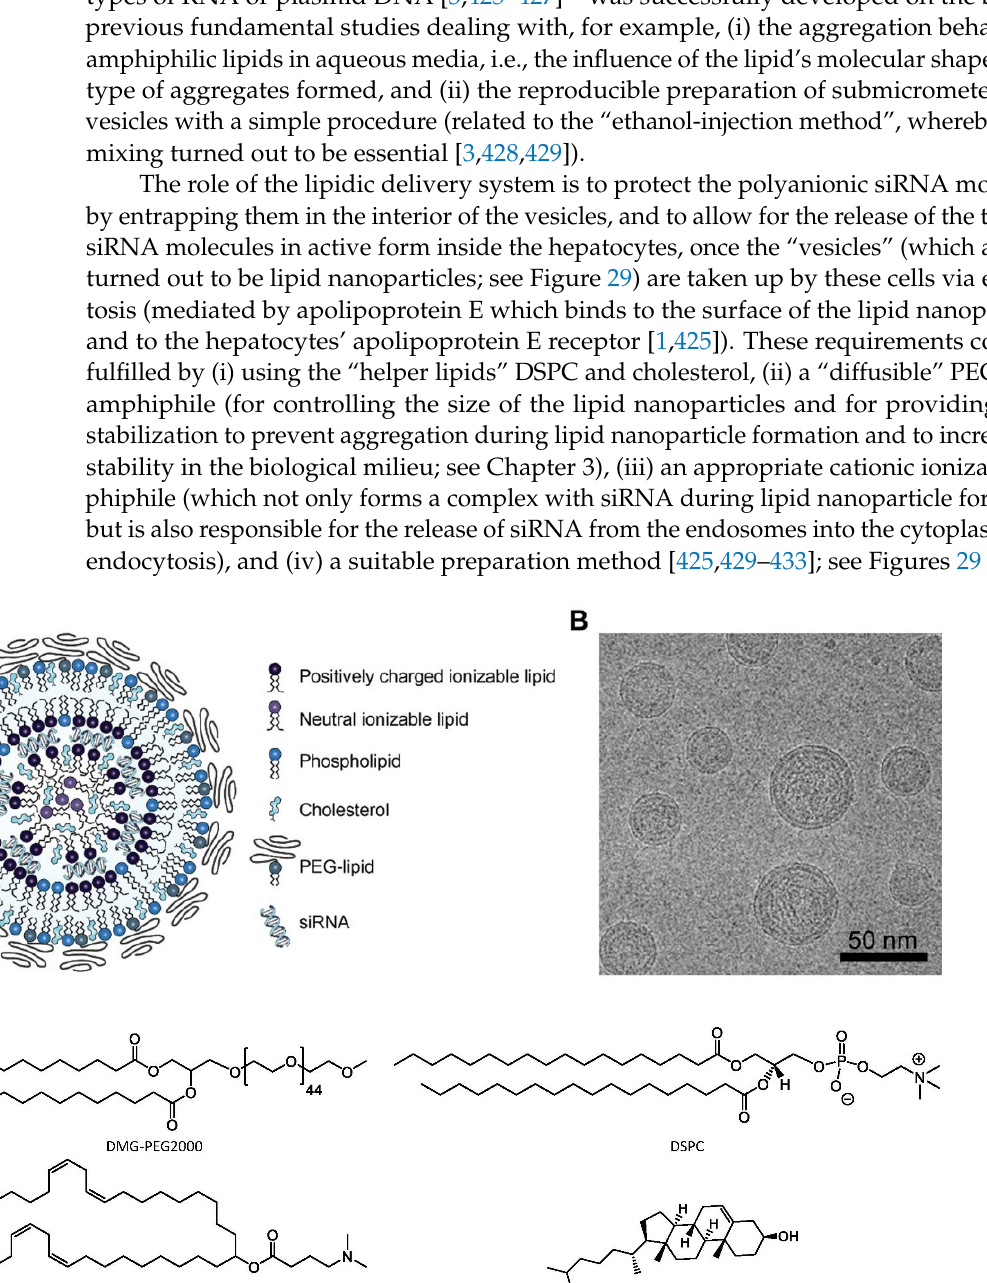
Figure 29. Morphology of the aggregates and chemical structures of the amphiphilic lipids present in Onpattro ® , an application of lipid nanoparticles (LNPs) for the delivery of siRNA to hepatocytes. Top : ( A ) Schematic representation of a cross-section through a spherical LNP containing entrapped siRNA, as published by Kulkarni et al. (2019) [429]. ( B ) Cryo-TEM image of a dispersion of siRNA-containing LNPs (bar: 50 nm) [429,430]. Bottom : Chemical structures of the lipids constituting the siRNA-containing LNPs, the phospholipid DSPC, cholesterol, the PEGylated lipid DMG-PEG2000 and the ionizable cationic lipid DLin-MC3-DMA, used at a molar ratio of 10:38.5:1.5:50 [429]. Reproduced with permission from [429], American Chemical Society, 2019.